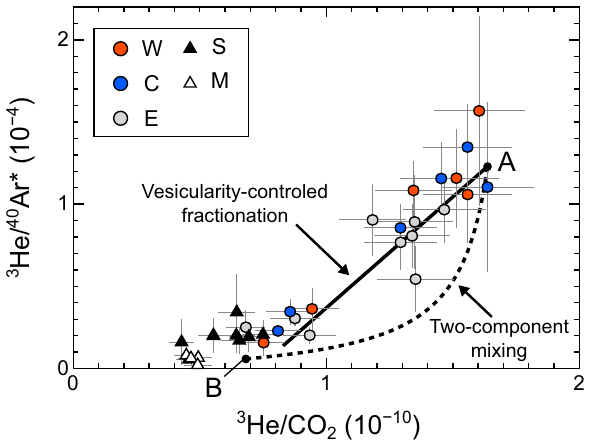
Figure 7. 3 He/ 40 Ar* versus 3 He/CO 2 diagram for the fumarolic gas samples. Samples with uncertainties of more than 70% in the 3 He/ 40 Ar* ratios are not shown. The straight line shows a relationship between 3 He/ 40 Ar* and 3 He/CO 2 ratios in the gas phase of a magma with a composition of “A” as a function of magma vesicularity. The relationship is computed using Eq. 6 with assumptions that the solubilities of He, Ar, and CO 2 in the magma are 5.7 × 10 −4 cm 3 STP g −1 bar −1 , 6.4 × 10 −5 cm 3 STP g −1 bar −1 , and 2.9 × 10 −4 cm 3 STP g −1 bar −1 , respectively 35,36 . The dashed curve represents a two-component mixing curve for gases with compositions of “A” and “B”. The points “A” and “B” are on the linear regression line for the Kitagawa fumarolic samples with the maximum (1.7 × 10 −10 ) and minimum (6.8 × 10 −11 ) 3 He/CO 2 ratios,